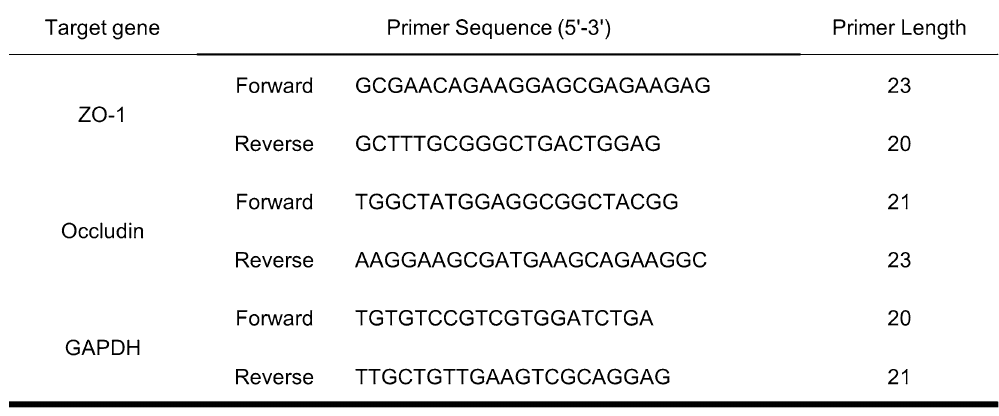
Table 1. Primer sequences was used in RT-qPCR assays in colonic